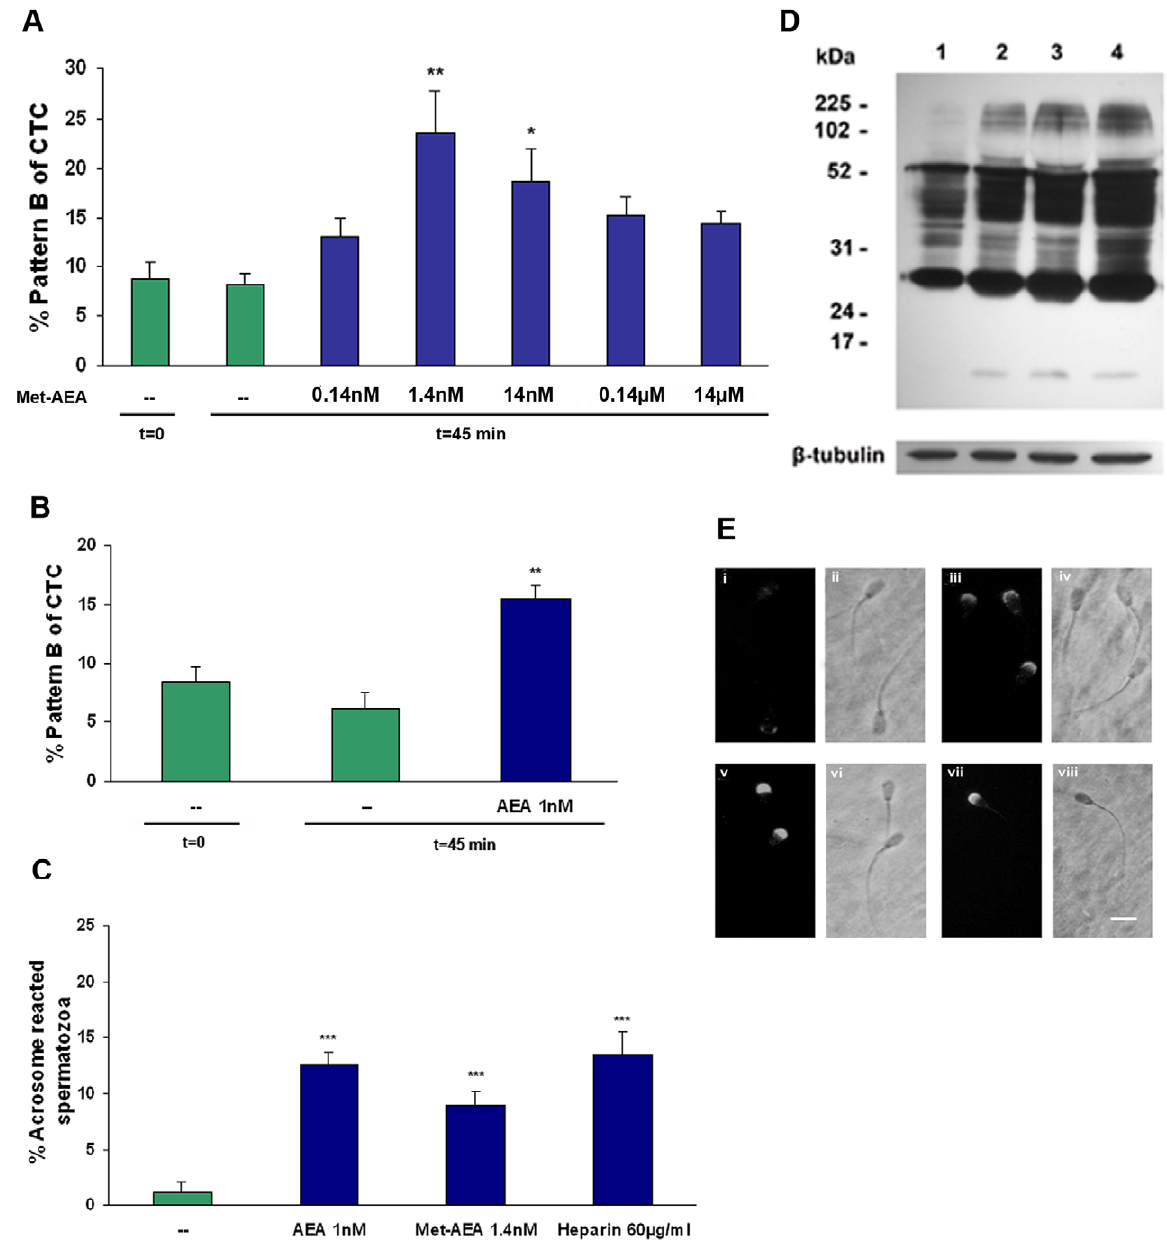
Figure 1. Effect of R( + )methanandamide (Met-AEA) and anandamide (AEA) on bull sperm capacitation. Spermatozoa were incubated for 45 min at 38.5 u C in sp-TALP medium with Met-AEA or AEA. Bars indicate the percentage of capacitated spermatozoa (A and B: % pattern B of CTC; C: % acrosome reacted spermatozoa). Data are expressed as mean 6 SEM. A, B : Assessment of sperm capacitation by CTC assay. A : Effect of increased concentrations of Met-AEA (0.14 nM-1.4 m M); (—) t=0 and t=45, sp-TALP at 0 and 45 min (control) incubation respectively (n=5). B : Effect of AEA (1 nM); t=0 and t=45 (controls) (n = 6). C : Assessment of sperm capacitation by LPC-induced acrosome reaction (AR)-PSA-FITC. Heparin (positive control) or (—) sp-TALP (control). Spermatozoa were incubated for 45 min at 38.5 u C in sp-TALP medium with Met-AEA (1.4 nM) or AEA (1 nM) and then were incubated for 15 min either with or without LPC to induce AR. Bars show percentage of spermatozoa that underwent LPC-induced AR minus the percentage of spermatozoa that underwent spontaneous AR (n=4). D : Evaluation of protein tyrosine phosphorylation. Sperm proteins were extracted and subjected to SDS-PAGE immunoblotting with a specific monoclonal antibody against phosphotyrosine (clone 4G10). Antibody against b -tubulin (50 kDa) was used as loading control. A representative experiment is shown. Numbers on the left-hand side of the gel represent the position of the relative molecular mass standards. Lane 1: sp-TALP (control), lane 2: Met-AEA (1.4 nM), lane 3: Heparin (60 m g/ml), lane 4: AEA (1 nM), (n=3). E : Immunolocalization of tyrosine phosphorylated-proteins in bovine spermatozoa. Panels i and iii: sp-TALP (control), panel v: Met-AEA (1.4 nM), panel vii: Heparin (60 m g/ml), panels ii, iv, vi, and viii: phase contrast (scale bar=10 m m). Specificity of the reaction was tested omitting the first antibody (Magnification, X400). *p , 0.05 vs control; **p , 0.01 vs. control; ***p , 0.001 vs. control.